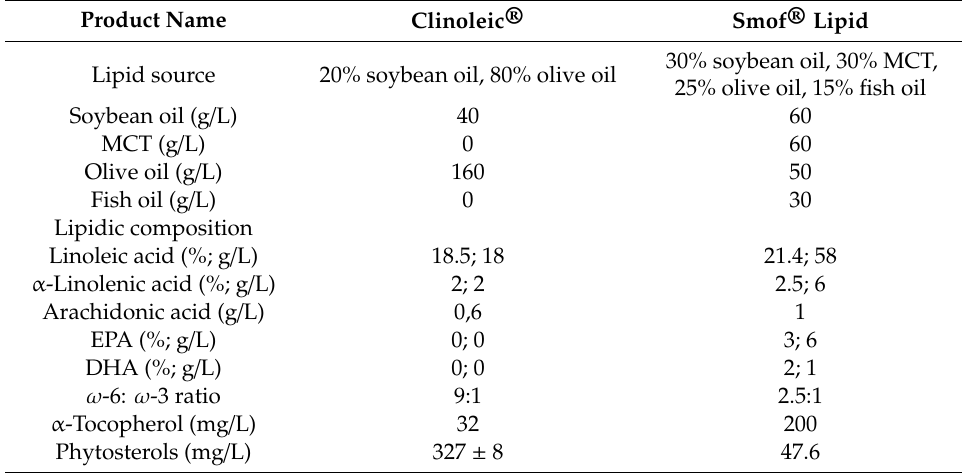
Table 2. Lipid emulsion composition; EPA: docosaesaenoic acid; EPA: eicosapentaenoic acid; MCT: medium chain triglycerides. Modified from